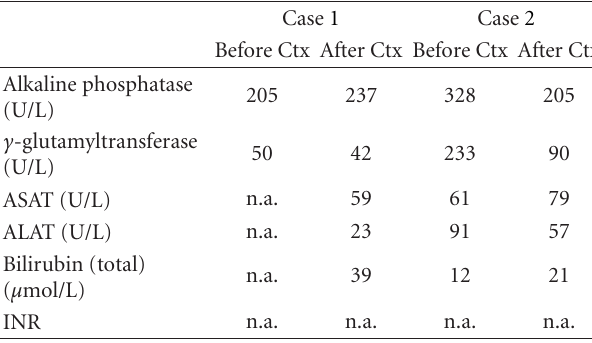
Table 1: Laboratory values of the patients described in Case 1 and Case 2 before and after administration of oxaliplatin-based neoadjuvant chemotherapy. Case 1